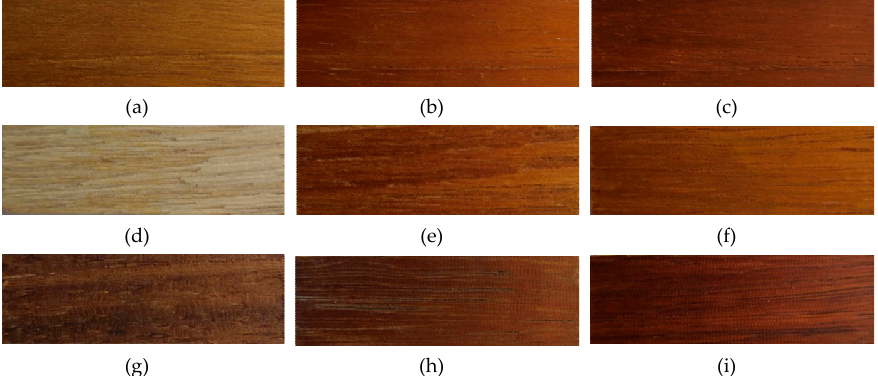
Figure 1. Surface morphologies of the three wood samples before and after aging. ( a – c ) Teak; ( d – f ) mabberley; ( g – i ) basralocus; ( a , d , g ) before aging; ( b , e , h ) after 733 days of natural sunlight aging; ( c , f , i ) after 180 h of xenon light